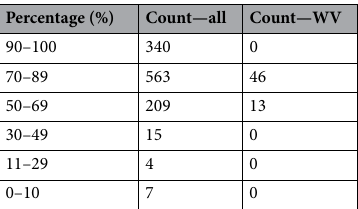
Table 1. Results of dingo ancestry testing for all individuals (Count—all) and for only the Western Victorian individuals (Count—WV). No WV hybrids were < 60%